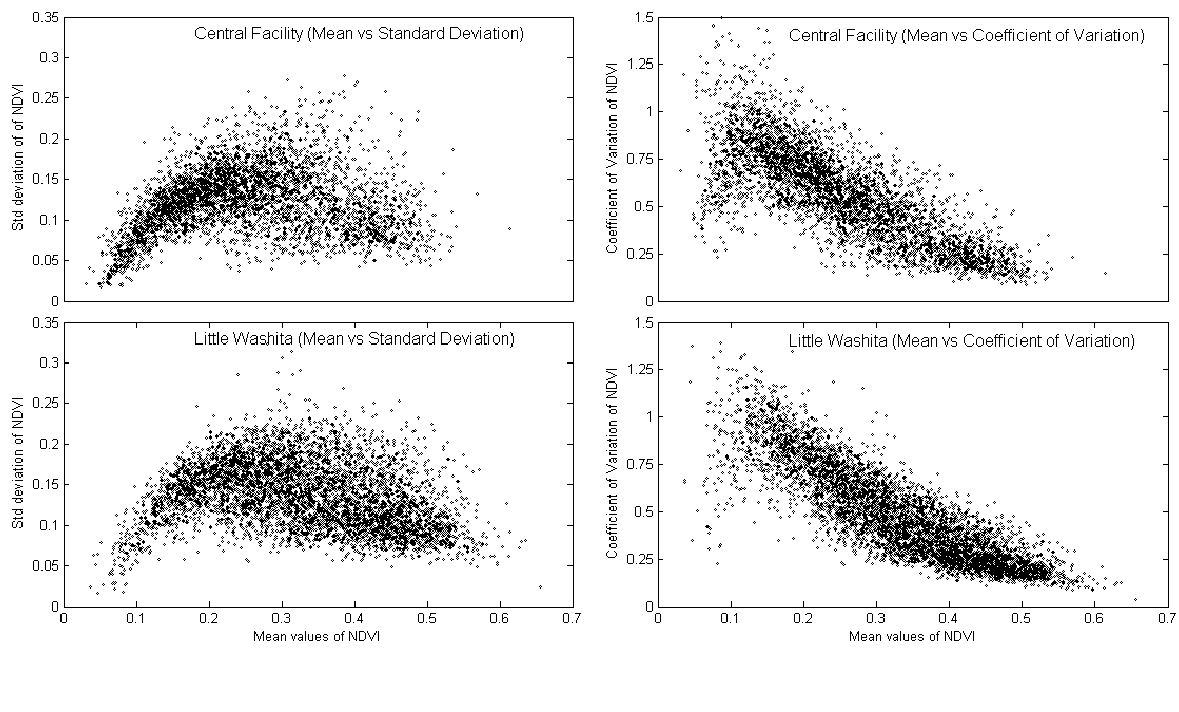
Figure 5. Relationship between NDVI mean to its variability (standard deviation) and coefficient of variation for Central Facility and Little